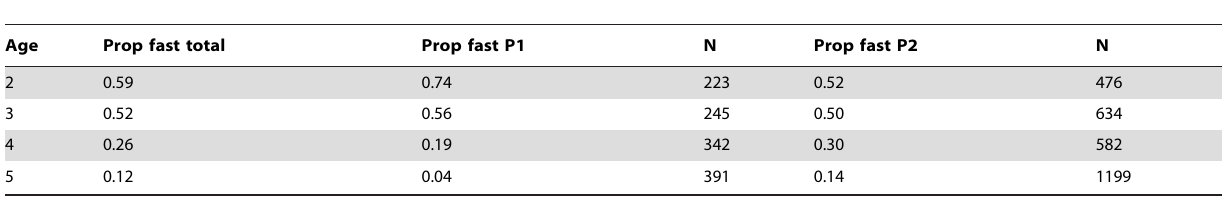
Table 3. Proportion of rapid growers for herring in age groups 2–5, in the sampling periods P1 (1960s) and P2